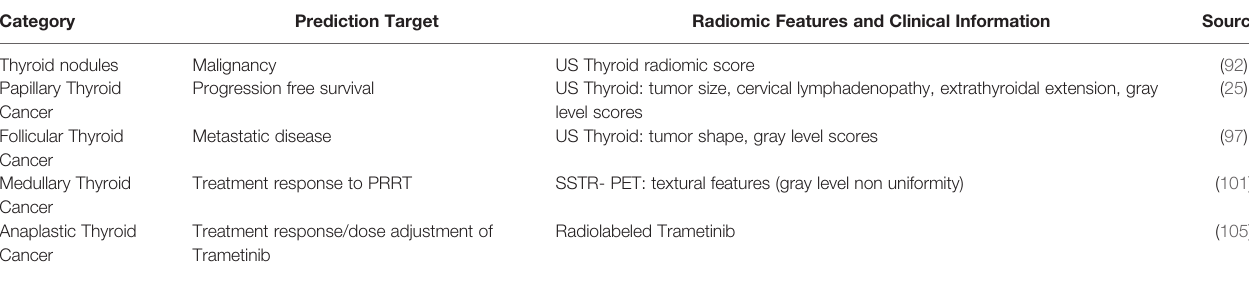
TABLE 2 | Summary of radiomic applications in thyroid